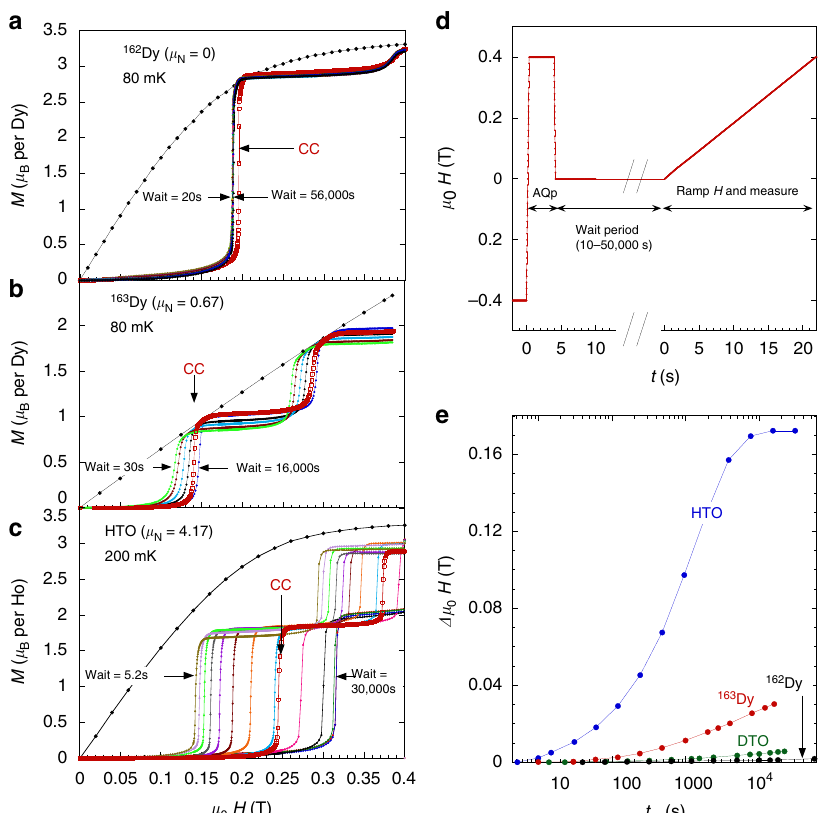
Fig. 4 Wait time and isotope dependences of magnetothermal avalanches. This gives further evidence of the effect of nuclear spins on the monopole mobility. Avalanches of the magnetisation were recorded while the fi eld was ramped at 20 mT s − 1 for a 162 Dy 2 Ti 2 O 7 ( 162 Dy) and b 163 Dy 2 Ti 2 O 7 ( 163 Dy), both measured at T = 80 mK, and c Ho 2 Ti 2 O 7 (HTO, measured at T = 200 mK). Magnetothermal avalanches for nat Dy 2 Ti 2 O 7 (DTO) can be seen in Supplementary Fig. 4. The samples were fi rst prepared using the AQP and then followed by various wait times (as outlined in ( d ) and discussed in methods) except for the curves marked CC, where the sample was fi rst prepared using the conventional zero fi eld cooled protocol (red squares). Also shown for each of the samples is the equilibrium M vs. μ 0 H taken at 900 mK (solid black dots). All measurements shown in the fi gure were made with the fi eld along the [111] axis; examples for other directions are given in the Supplementary Figs. 9 – 11. e Plot of difference in avalanche fi eld Δ H H t = minimum) against log wait time for the data shown in the left as well as nat Dy ava ( w